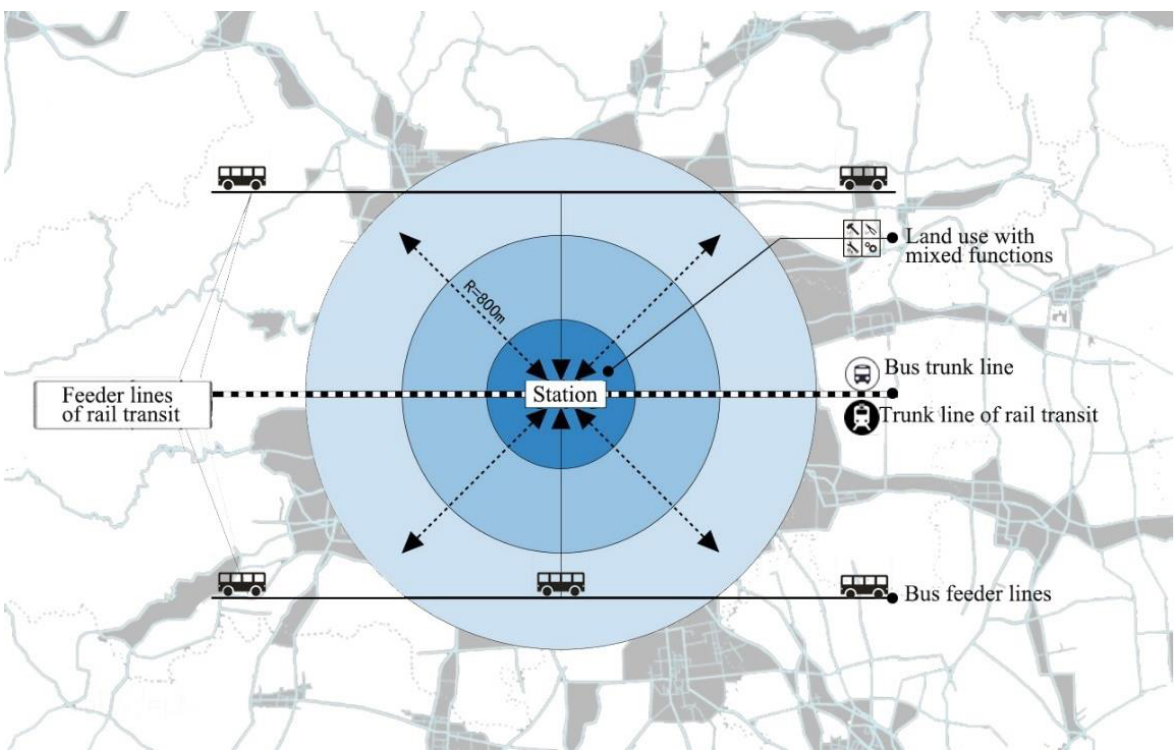
Figure 1. Transit-oriented development mode of city.